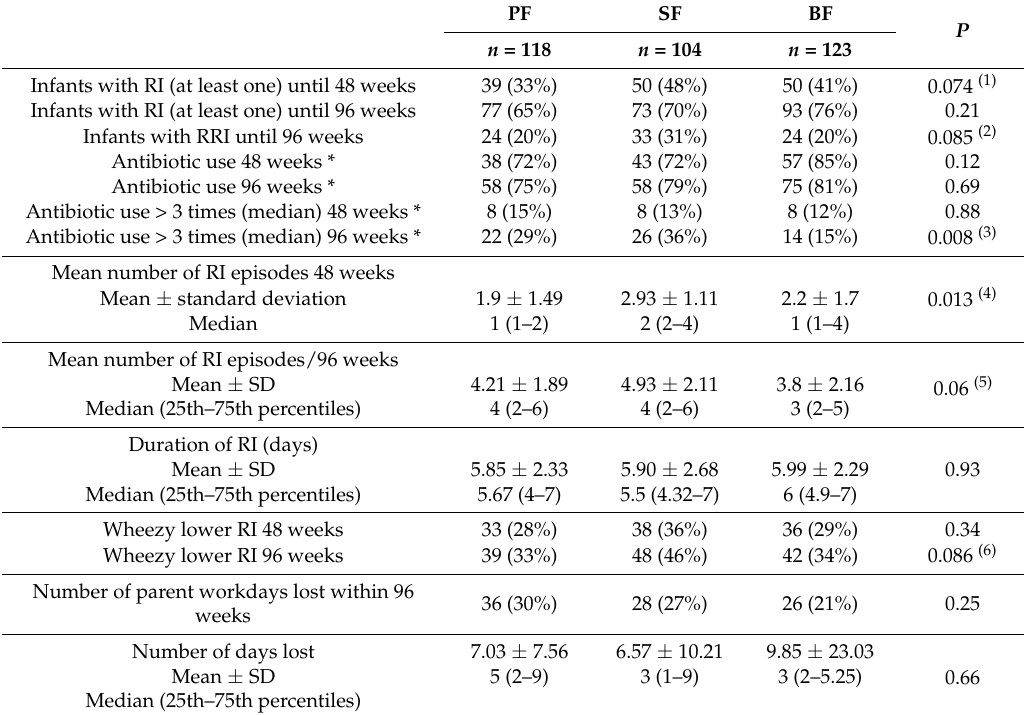
Table 4. Respiratory infections (RI) parameters and incidence of wheezy lower RI among the three groups.